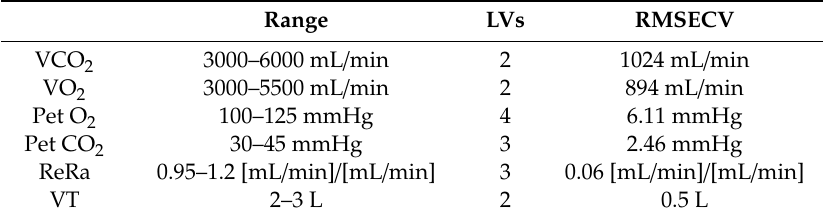
Table 3. Model parameters obtained using a fusion of saliva and exhaled breath data.